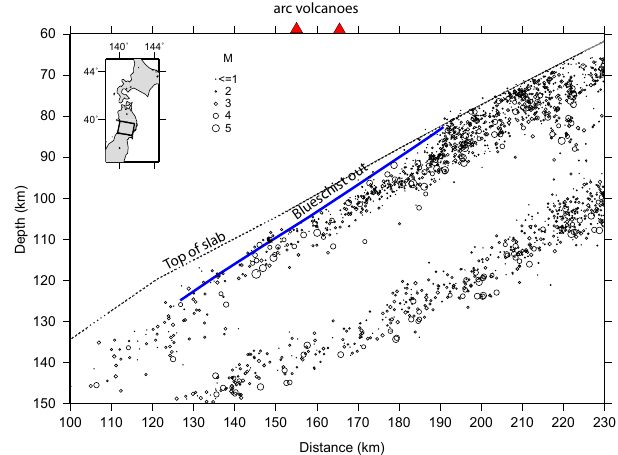
Fig. 2. Seismicity in the Pacific slab below Tohoku. Modified after Kita et al. (2006) and Abers et al. (2012). The earthquakes from 120km wide box shown in the insert are projected on the center cross section, normal to the trench. This region is approximately bordered by profiles T9 and T18 in Fig. 1. The upper plane of seis- micity is within 10km (in depth) from the top of the slab and tends to be deeper in the slab as the slab descends. The blueschist-out boundary (predicted for this profile following the methods by van Keken et al., 2011) seems to delimit the deepest seismicity in the upper